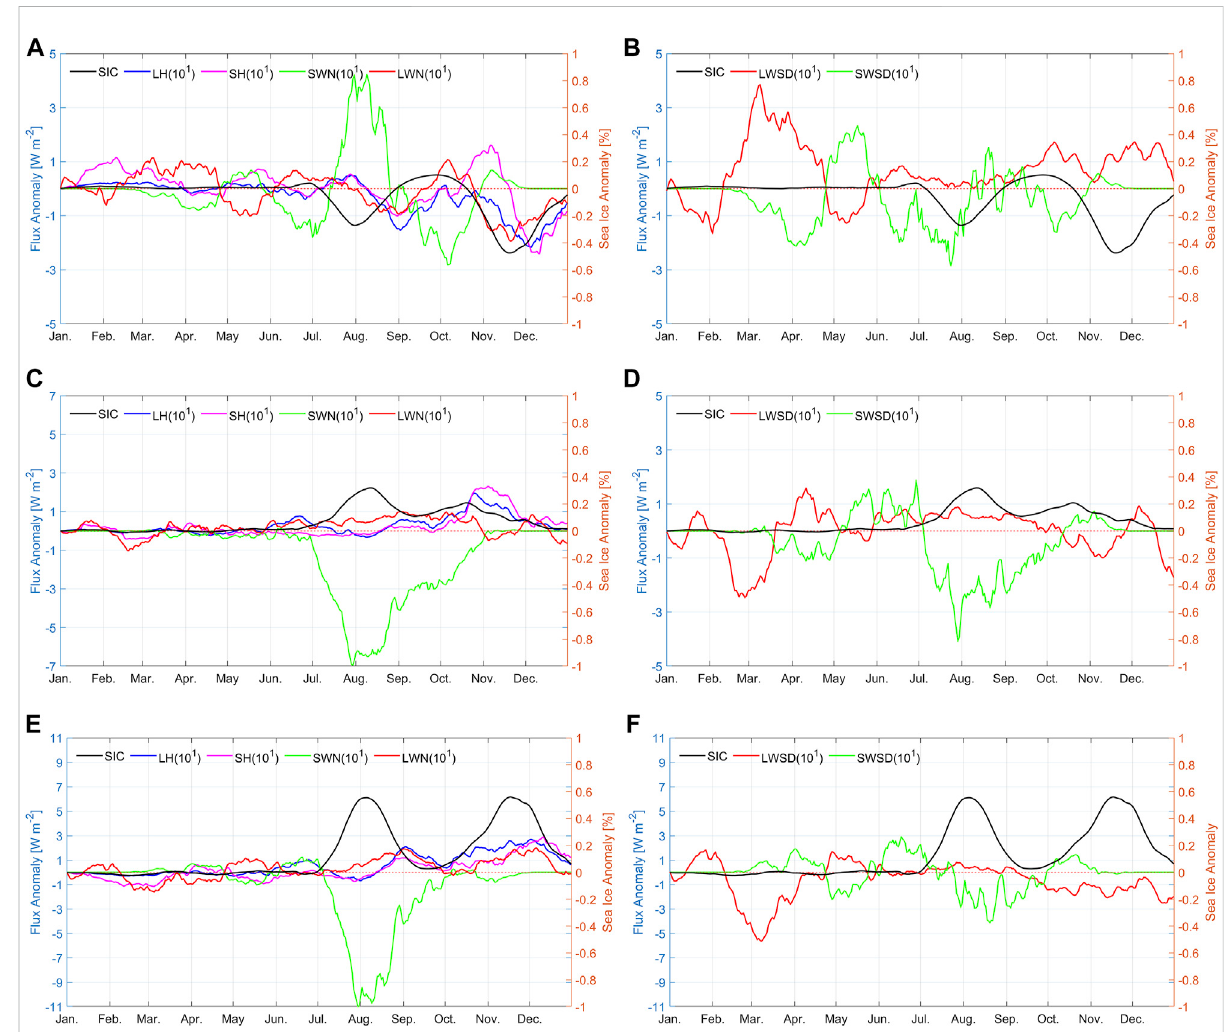
FIGURE 4 Radiative and turbulent fl ux anomalies at the surface for 2019 [top, (A,B) ], 2020 [middle, (C,D) ] and 2020 minus 2019 [bottom, (E,F) ] using method one. The black line shows the SIC (right – hand axis). (A,C,E) , the latent fl ux (LH; blue), the sensible fl ux (SH, pink), the netshortwave radiation (SWN;green)andthenetlongwaveradiation(LWN;red). (B,D,F) ,downwellinglongwave(LWSD;red)andshortwave(SWSD;green)radiation.Alltime series are averaged over the area 73 – 75 ° N by 168 – 150 °